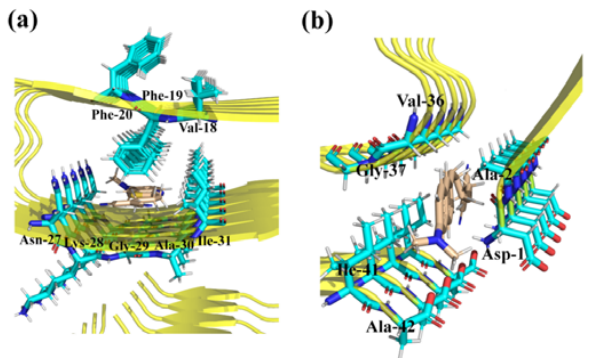
Figure 2. Binding sites of ( a ) P1, ( b ) P2, and ( c ) P3 in β -amyloid.